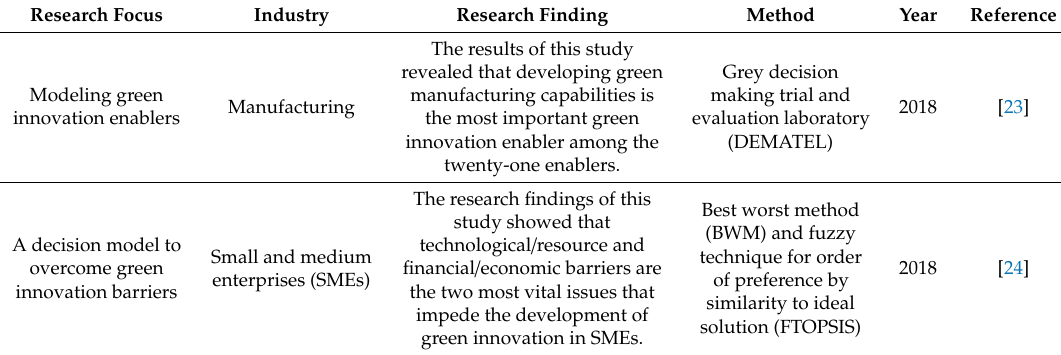
Table 1. Relevant multi-criteria decision making (MCDM) based studies on the assessment of green innovation for sustainable supply